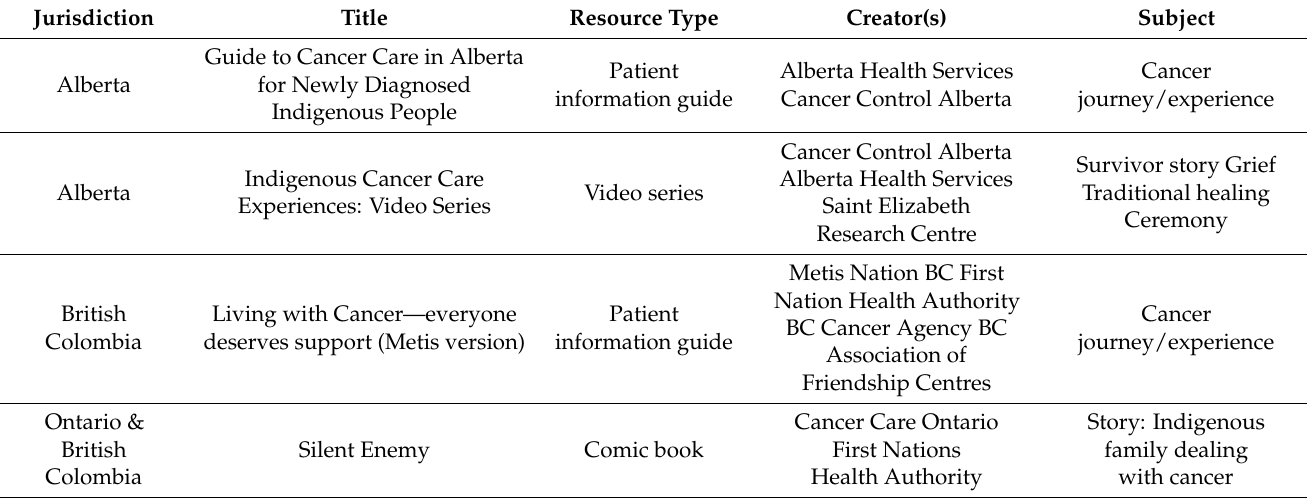
Table 6. Cancer educational materials for FNIM